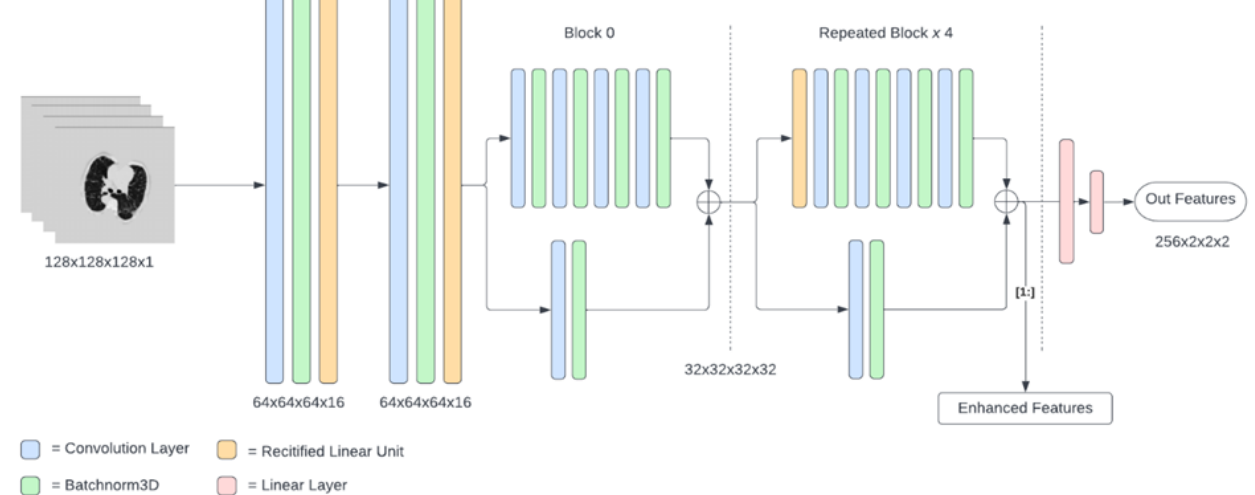
Figure 3. Schematic of the AlignedXception model.